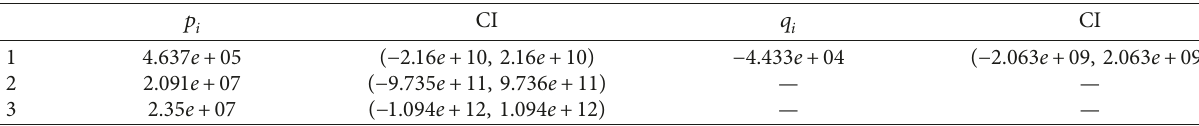
Table 9: GA vs. HoF.